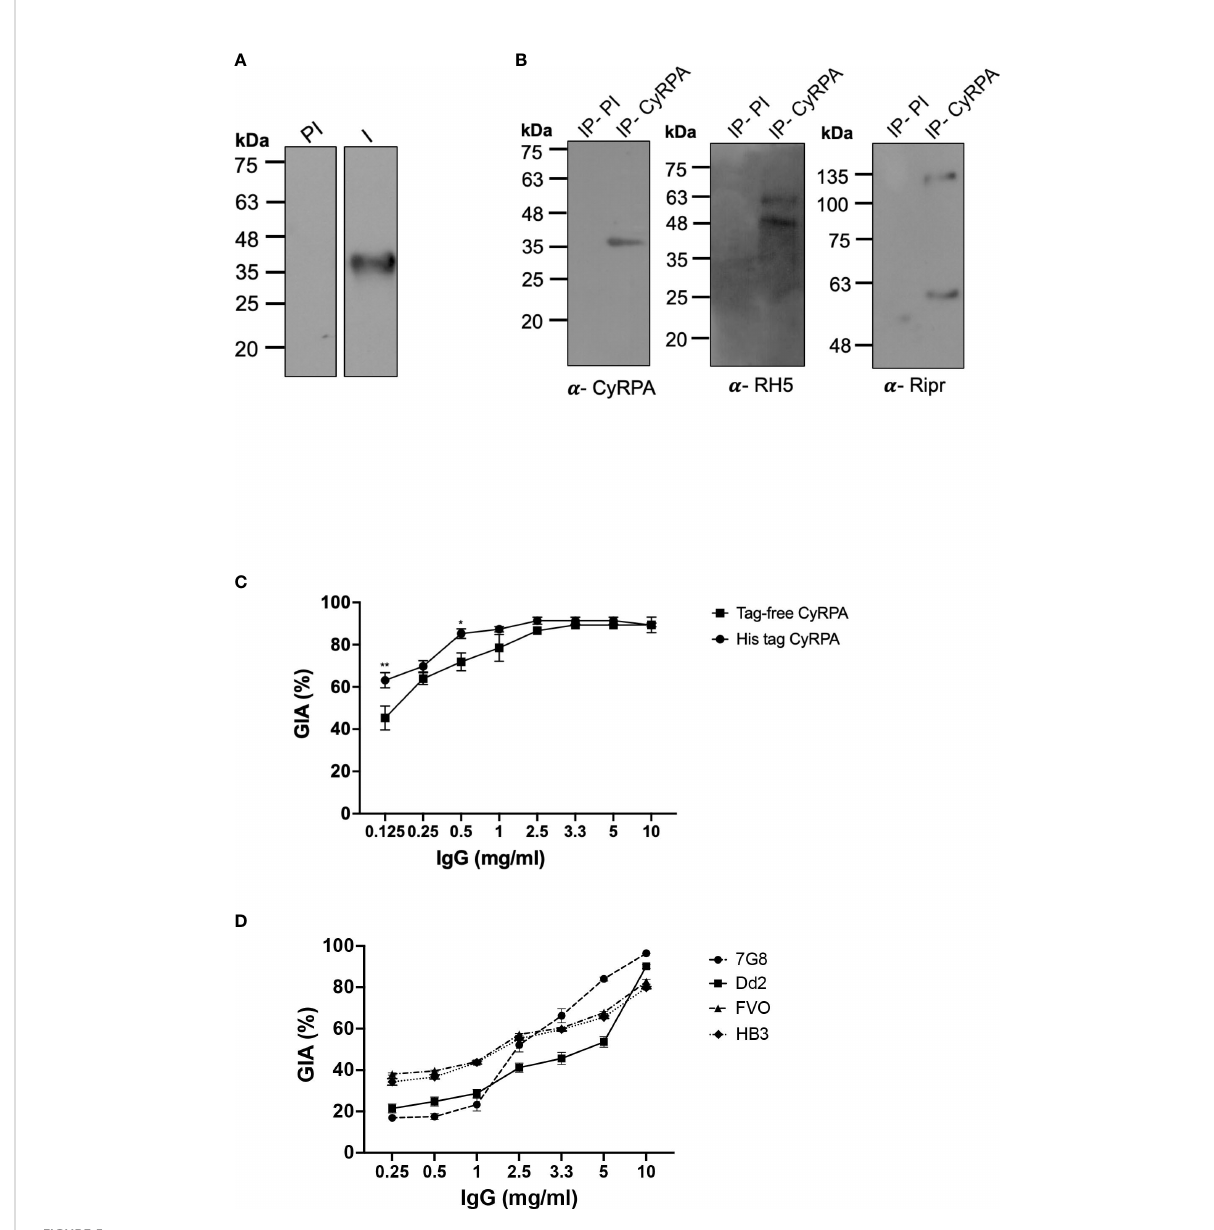
FIGURE 5 Parasite Neutralizing Ability of Antibodies Targeting Tag- Free CyRPA. (A) Antibodies raised against tag-free CyRPA were evaluated for speci fi city by their ability to recognize native CyRPA protein. Schizont extracts from 3D7 parasites were probed with anti-CyRPA immune (I) and pre- immune (PI) rabbit polyclonal sera through immunoblotting. Immune sera speci fi cally detected a band at ~40 kDa corresponding to CyRPA, while no signal was detected with the pre-immune sera. (B) To con fi rm the ability of CyRPA rabbit antibodies to detect the native protein in its native form, co-immunoprecipitation experiment was performed with 3D7 schizont lysate. As shown, the co-immunoprecipitated components of the multi-protein complex (RH5, Ripr and CyRPA) were successfully detected using their respective speci fi c rabbit antibodies in immunoblotting. Pre-immune sera, used as a negative control, could not coimmunoprecipitate the multiprotein complex. (C) Puri fi ed rabbit total IgG against tag-free CyRPA were tested in the standard in vitro Growth Inhibitory Assay (GIA) against 3D7 clone in a one-cycle assay. The antibodies exhibited highly potent dose-dependent parasite neutralization reaching saturation at 2.5 mg/ml with ~90% inhibition levels. The antibody ef fi cacy was similar to those against (6-His) tagged CyRPA that was used as a positive control except at low concentrations of 0.125 and 0.5 mg/ml. Data represents the average of 2 independent experiments conducted in duplicate. The error bars represent the standard error between the 2 independent GIA experiments. The P values were calculated by two-way ANOVA with Bonferroni post-hoc testing. (D) Total IgG against tag-free CyRPA was tested against four P. falciparum clones- 7G8, Dd2, FVO and HB3, in a one-cycle GIA. A robust strain transcending parasite neutralization activity was observed by the antibodies across the four strains with inhibition levels reaching to ~80% to 96%. Data represents the average of 2 independent experiments conducted in duplicate. The error bars represent the standard error between the 2 independent GIA experiments. I, Immune; PI, Pre-immune; IP,